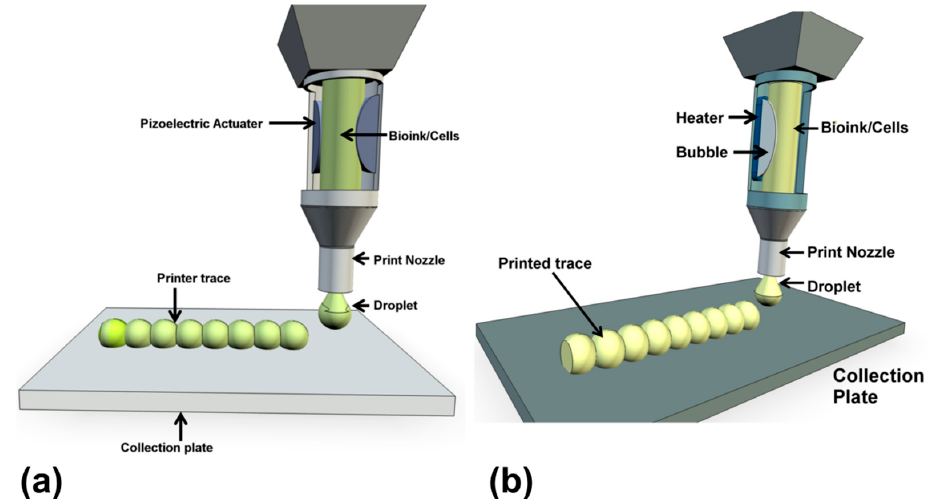
Figure 3. A representation of inkjet bioprinting of stem cell. Droplets of a stem cell bearing bioink are formed from the reservoir by the action of a piezoelectric ( a ) or thermal actuator ( b ) to be deposited on a collection plate.